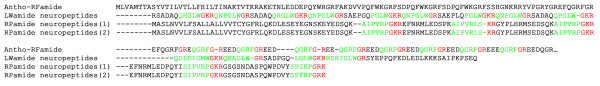
Amino acid sequence alignment of precursors of LWamide neuropeptides (Q16998), N-terminal fragment of Antho-RFamide (Q01133) and novel RPamide neuropeptides retrieved with motif K. Active neuropeptides are shown in green, identical enzymatic processing sites in precursors are given in red.